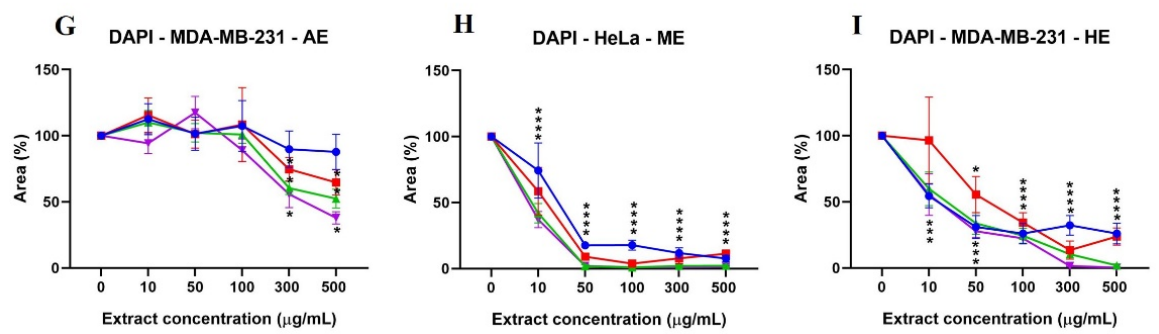
Figure 6. Cell behavior against different concentrations of A. monostachya extracts by nuclei labeling with DAPI. Comparisons of the effects of AE, ME, and HE on the cell lines: Vero ( A – C ), HeLa ( D – F ), and MDA-MB-231 ( G – I ) after exposure to the extracts at 12 h (blue line), 24 h (red line), 48 h (green line), and 72 h (purple line). The graphs show the % area as a function of the concentration of the extracts. It can be seen that HE has a greater cytotoxic effect on the tumor cell lines at 24 h and later. The HeLa cells showed a lower percentage of the area after exposure to the extracts. * p < 0.05, Tukey’s multiple comparison test vs. vehicle-treated cells.